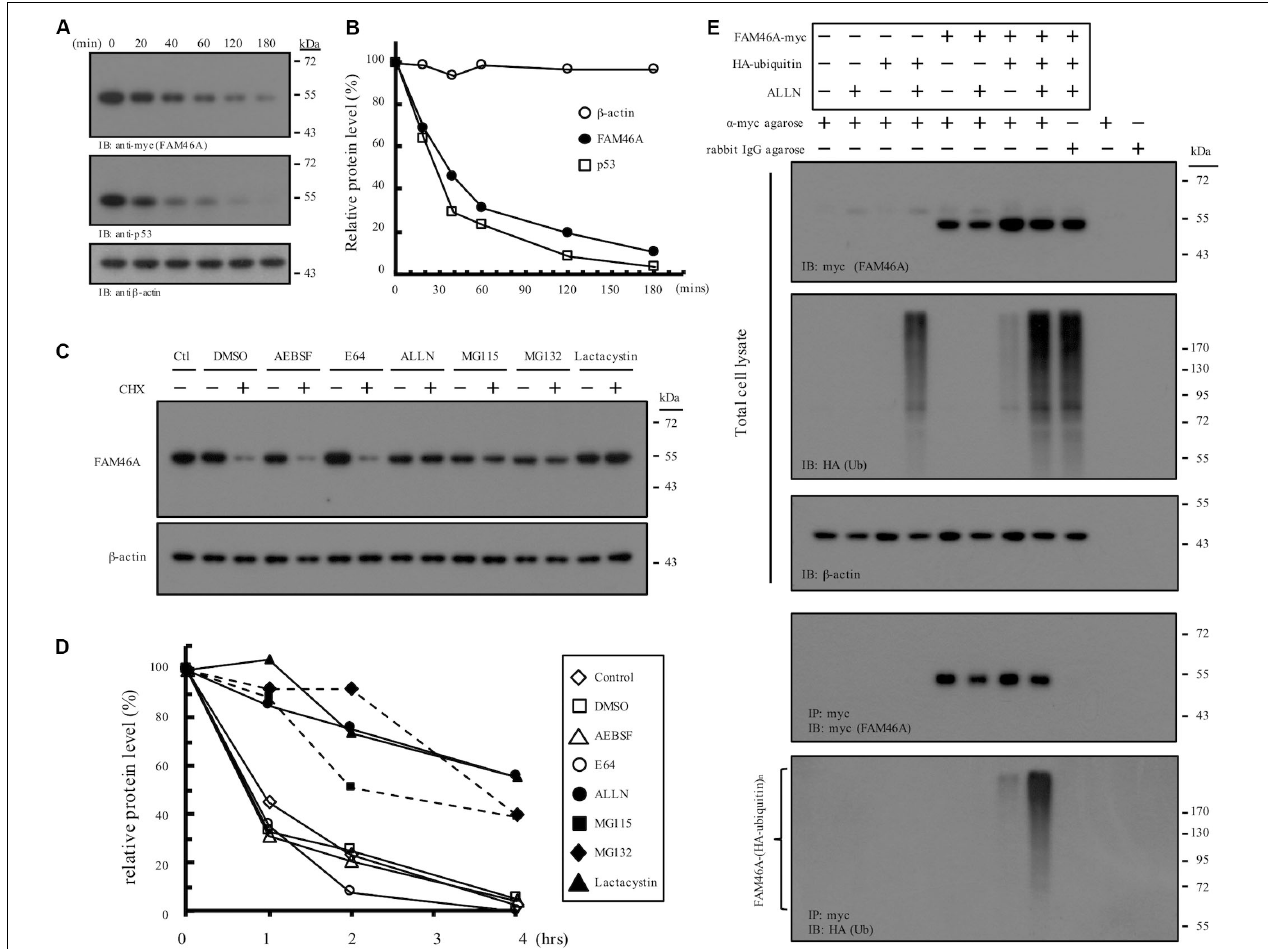
FIGURE 4 | Molecular characterization of FAM46A protein stability and turnover. (A,B) FAM46A is a short-lived protein. (A) Western blot analysis of the FAM46A-myc protein in transfected HeLa cells treated with cycloheximide (20 µ g/ml). Total cell lysates were collected at different time points (minutes) shown at the top of the panels. Blots were probed with Abs to detect FAM46A, p53 and β -actin as indicated. (B) The estimation of the half-life of the indicated proteins. The intensity of the protein bands depicted in (A) was determined by the densitometer and all values were calculated as a percentage of the starting protein level at time 0. Protein half-life was determined by calculating the time required to achieve 50% of the initial protein level. The data shown were the representatives of three independent experiments with similar results. (C,D) FAM46A protein expression was stabilized in the presence of proteasome inhibitors. (C) Western blot analysis of the FAM46A protein expression levels in transfected HeLa cells treated with various protease/proteasome inhibitors in the presence or absence of cycloheximide (CHX, 20 µ g/ml) for 4 h. For CHX treatment, CHX was added 1 h after the addition of protease/proteasome inhibitors. Blots were probed with the anti-myc Ab to detect FAM46A. Expression of β -actin was included as a loading control. (D) Changes in half-life of the FAM46A protein following treatment of protease/proteasome inhibitors. All values were calculated as a percentage of the starting protein level at time 0. (E) FAM46A is modified by poly-ubiquitylation. HeLa cells were co-transfected with the FAM46A-myc and HA-tagged ubiquitin expression constructs as indicated. Cells were treated with either DMSO (–) or 100 µ M ALLN (+) for 16 h. Whole cell lysates were subjected to immunoprecipitation using rabbit anti-c-myc agarose conjugate. Blots were probed with the anti-myc and anti-HA mAbs to detect FAM46A and ubiquitylated proteins, respectively. Expression of β -actin was included as a loading